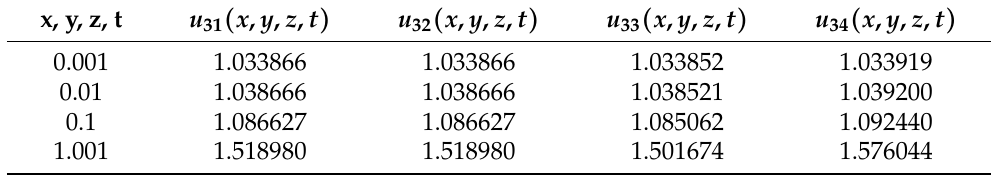
Table 3. Numerical solutions for three wave solutions of